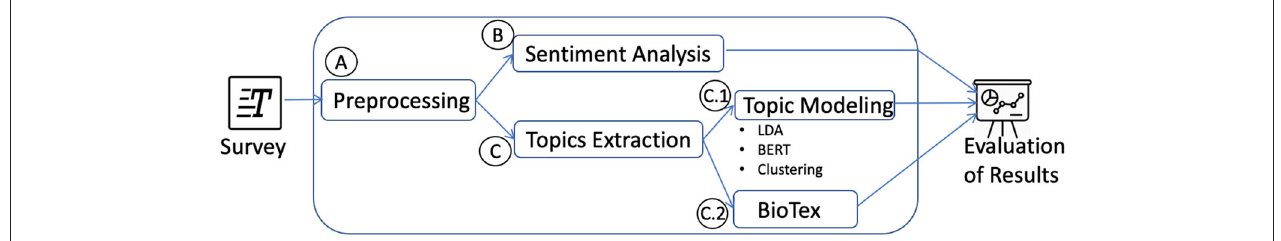
FIGURE 1 | Workflow of the Natural Language Processing methods applied to analyze the text of the survey.